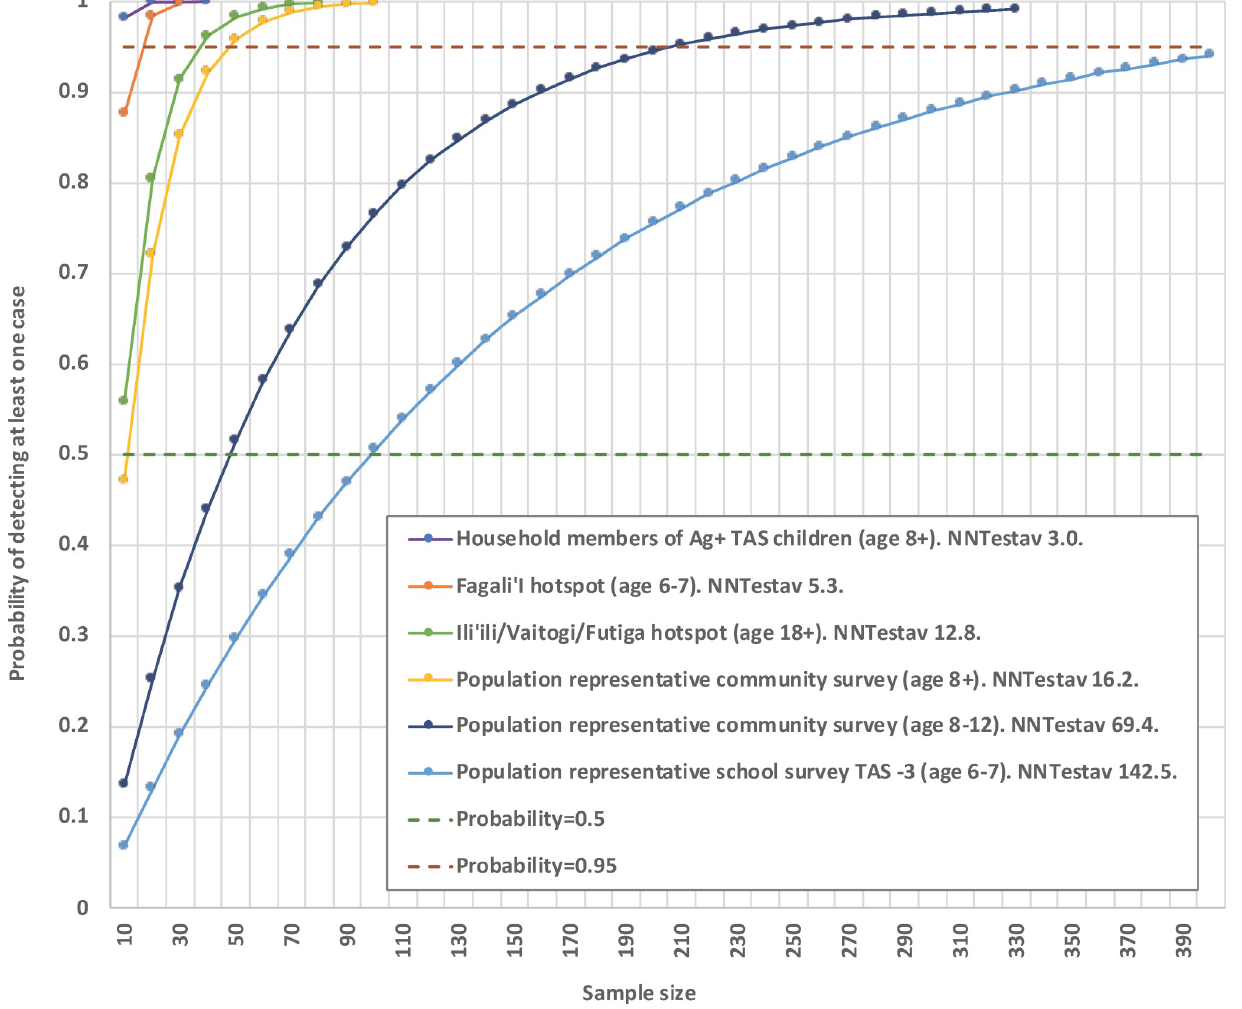
Fig 11. Probability of detecting at least one Ag-positive case based on sample size and selected survey strategies with different levels of NNTest av (assumes that Ag-positive cases are independent events). Strategies shown include population representative surveys of 6–7 year-olds, 8–12 year-olds, and those � 8 years old; hotspot villages; and household members of Ag-positive children identified in TAS (index children).